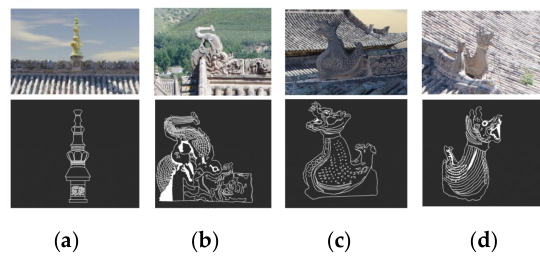
Figure 8 . (a) Retention information of the decorative components: (a) Baoping; (b) Chiwen; (c) Chuishou; (d)